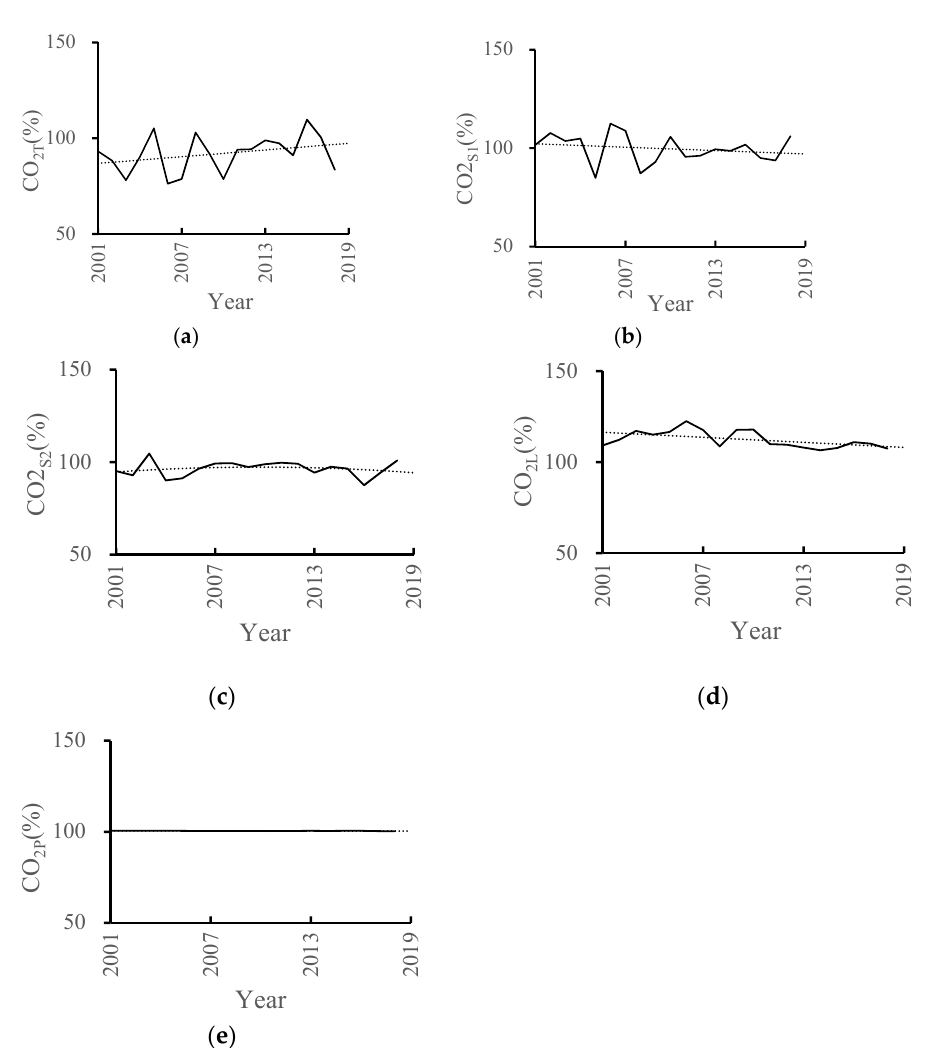
Figure 1. The results of summation and decomposition of total driving effects (units: 10,000 tons). After analyzing the total effect of each driving factor, using the additive form of the LMDI method, we went on to use a multiplicative form of the LMDI method to analyze the contribution of each driving factor. Figure 2 shows the change in the contribution of each driving factor from 2001 to 2019 in animal husbandry.